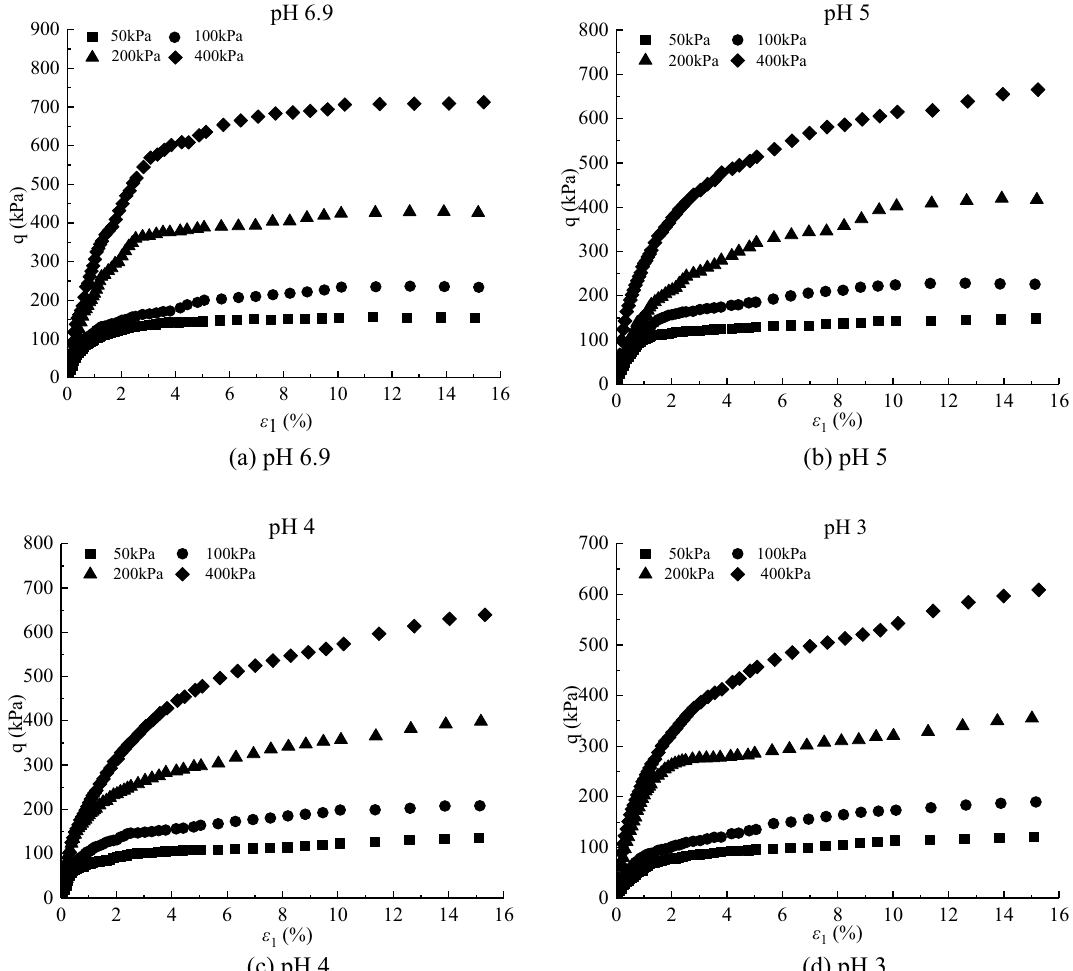
Figure 1. Experimental results of deviatoric stress–axial strain curves of loess samples under different confining